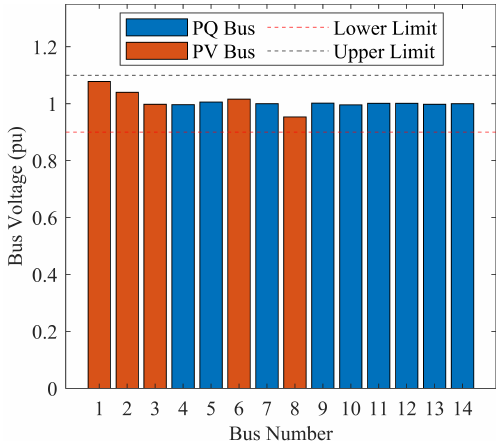
Figure 5. Bus voltages of the IEEE 14 bus test system.